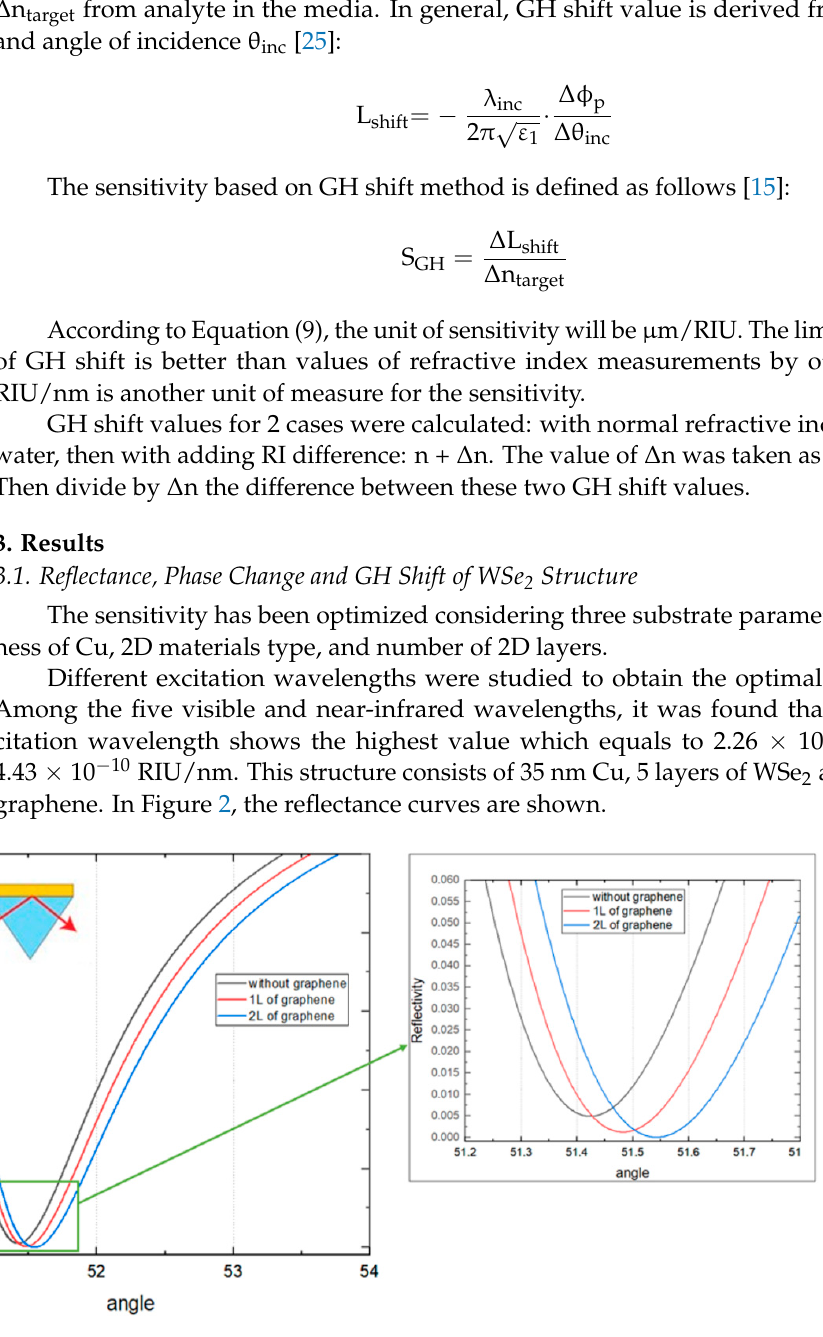
Figure 2. Reflectivity of the structure with 5 layers of WSe 2 and 35 nm of Cu depending on the angle of incidence (degrees). of incidence